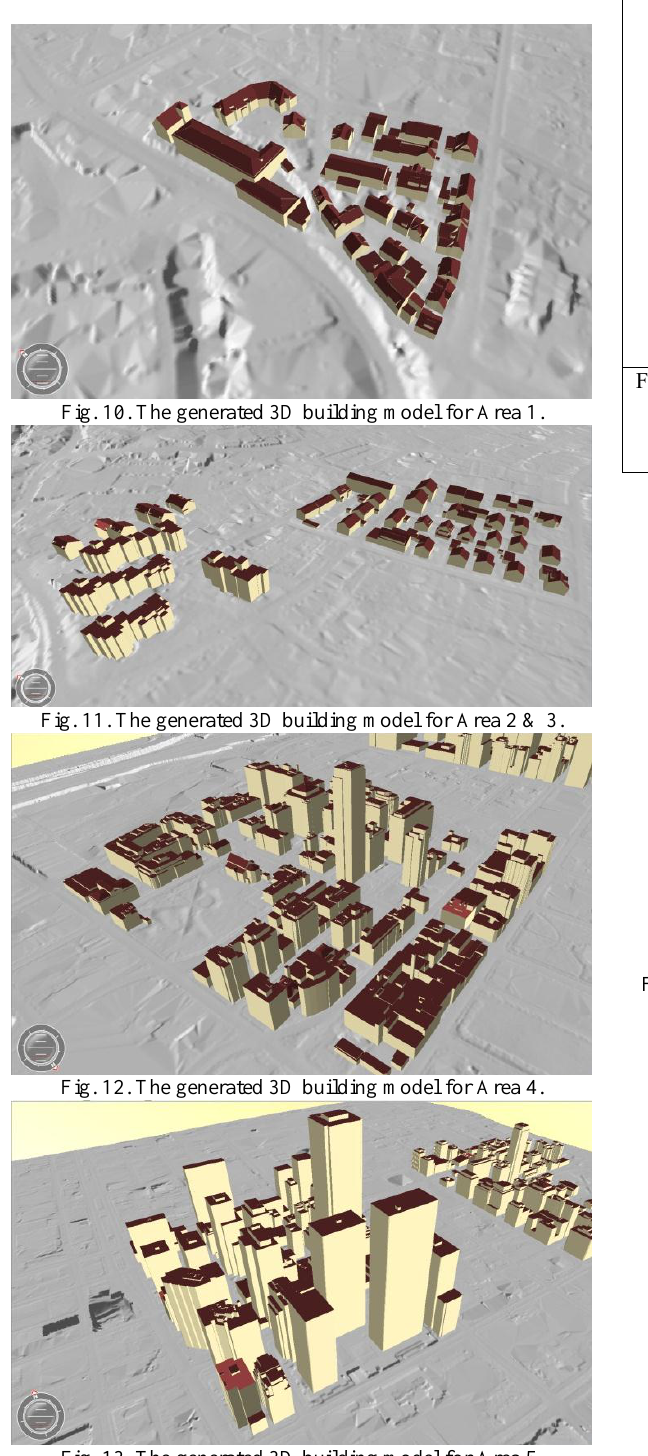
Fig. 13. The generated 3D building model for Area 5.